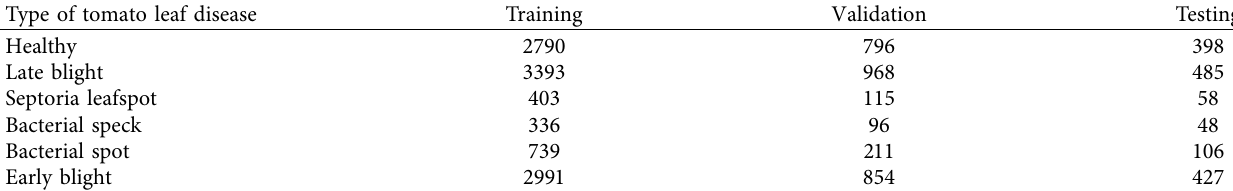
Table 2: Distribution of the field-based dataset for training, validation, and evaluation.